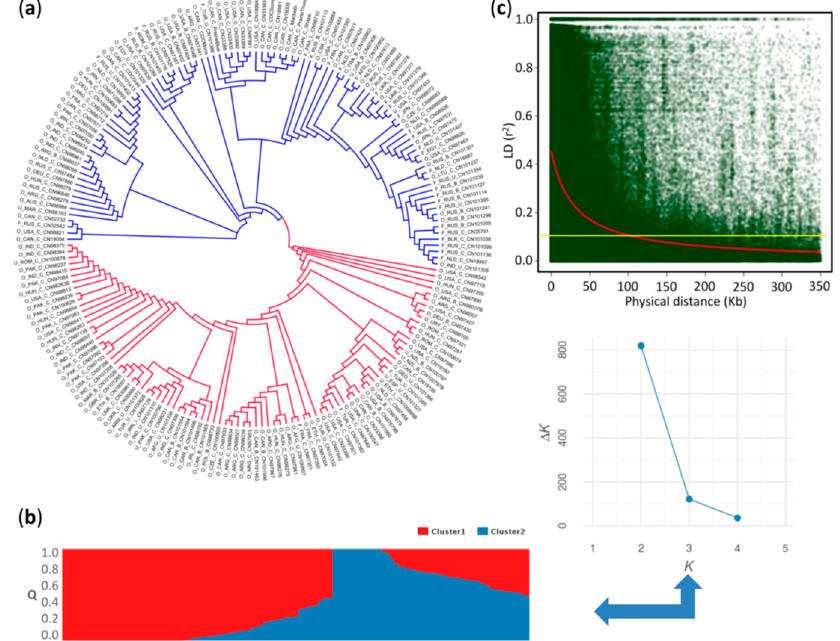
Figure 2. Population structure and genome-wide linkage disequilibrium decay. ( a ) Neighbor-joining (NJ) tree for 200 flax accessions based on 779,914 single nucleotide polymorphisms (SNPs); ( b ) Model-based population structure of 200 flax accessions belonging to two clusters predefined by the STRUCTURE software. Each accession is represented by a vertical bar. The color subsections within each vertical bar indicate membership coefficient (Q) to different clusters; ( c ) Genome-wide linkage disequilibrium decay of r 2 values (red line), against physical distance (kb) using the Hill and Weir (1988) function in L. usitatissimum . Yellow line indicates the cutoff value ( r 2 = 0.1) used to determine the genome-wide linkage disequilibrium (LD) block size.